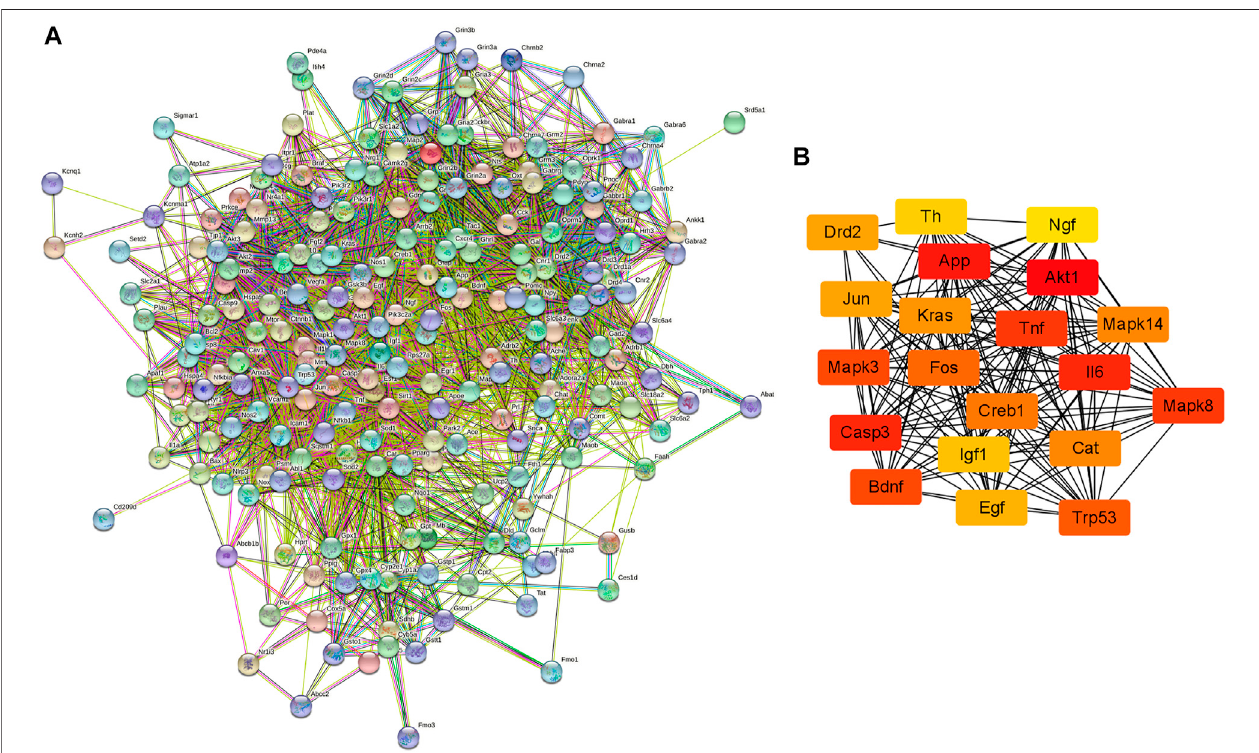
FIGURE5| PPInetworkofthepotentialtargetgenesandhubgenesscreen. (A) ThePPInetworkofthepotentialtargetgeneswasconstructed usingSTRING. (B) The most signi fi cant hub genes were obtained from the PPI network using Cytoscape and CytoHubba.